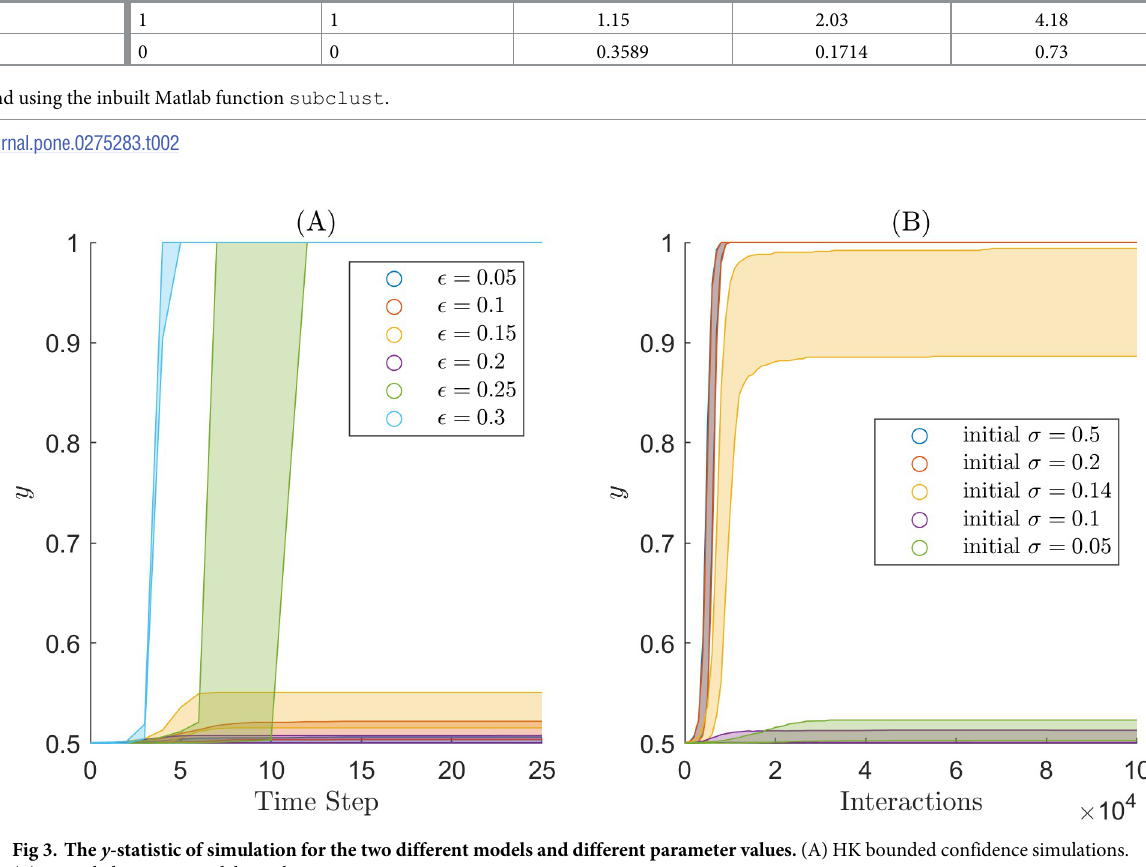
Fig 3. The y -statistic of simulation for the two different models and different parameter values. (A) HK bounded confidence simulations. (B) Extended Martins model simulations.